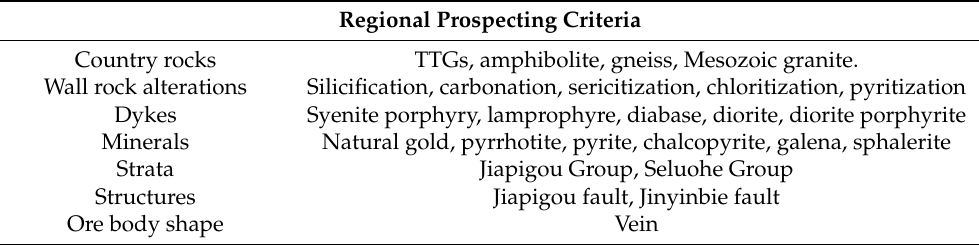
Figure 19. The geological model for the prospecting prediction of typical deposits in the JGMB based on the KG. Table 12. Regional prospecting criteria of the